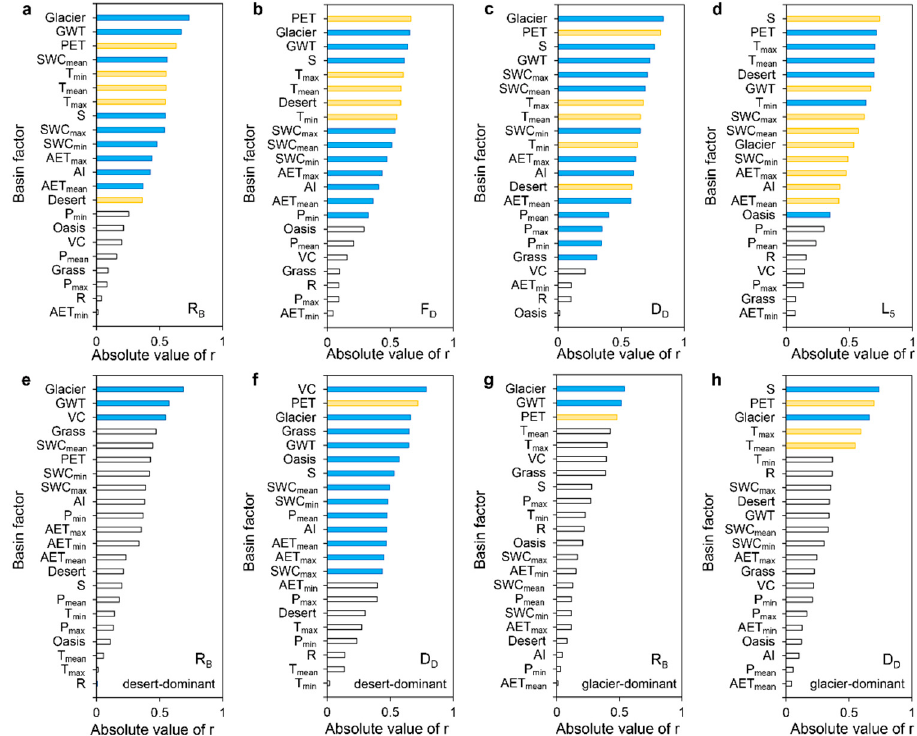
Figure 6. Correlation between structure parameters of endorheic rivers and basin factors. Spearman correlation coefficient ( r ) of: ( a ) bifurcation ratio (R B ); ( b ) fractal dimension (F D ); ( c ) drainage density (D D ); ( d ) mean length of the rivers at stream-order 5 (L 5 ) for the 60 sub-basins in the Tarim River basin. ( e , f ) are r values for desert-dominant sub-basins. ( g , h ) are the r values for glacier-dominant sub-basins. The blue and yellow histograms, respectively, represent significantly positive and negative correlations, whereas the white histogram represents no correlation observed.